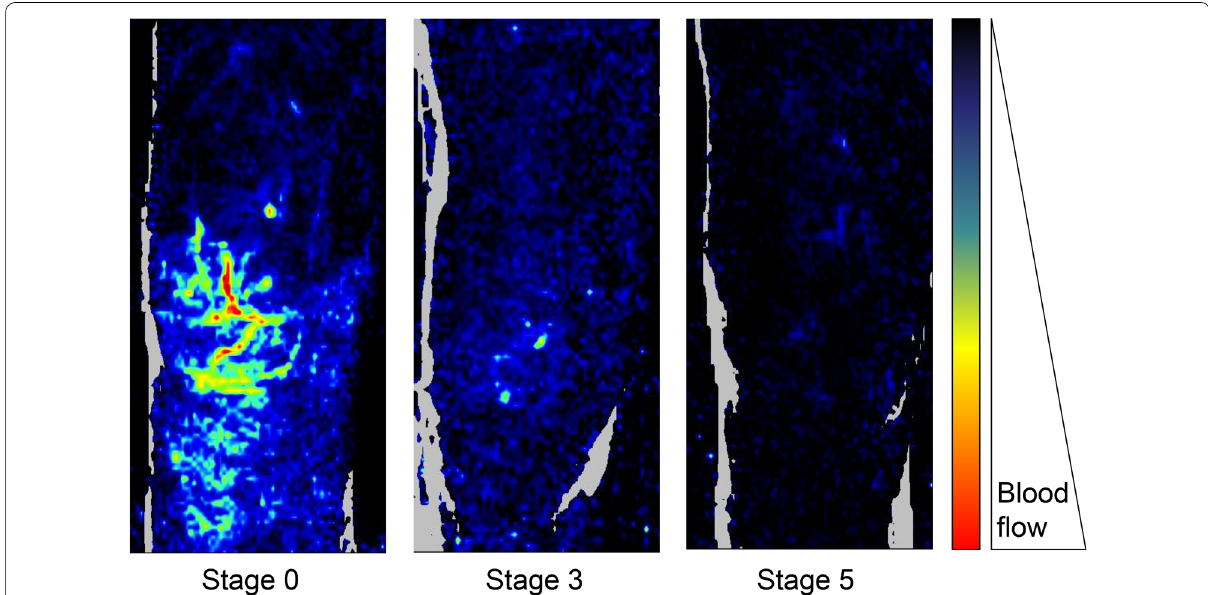
Fig. 1 Examples of skin microvascular perfusion evaluation using laser Doppler imaging in the knee area according to the mottling score. Skin perfusion decreases when mottling score worsens. Adapted from [9]